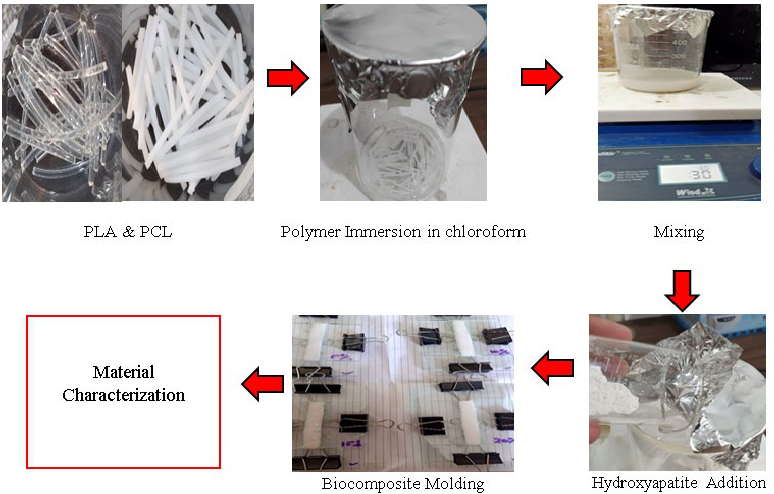
Figure 2. Experimental setup.